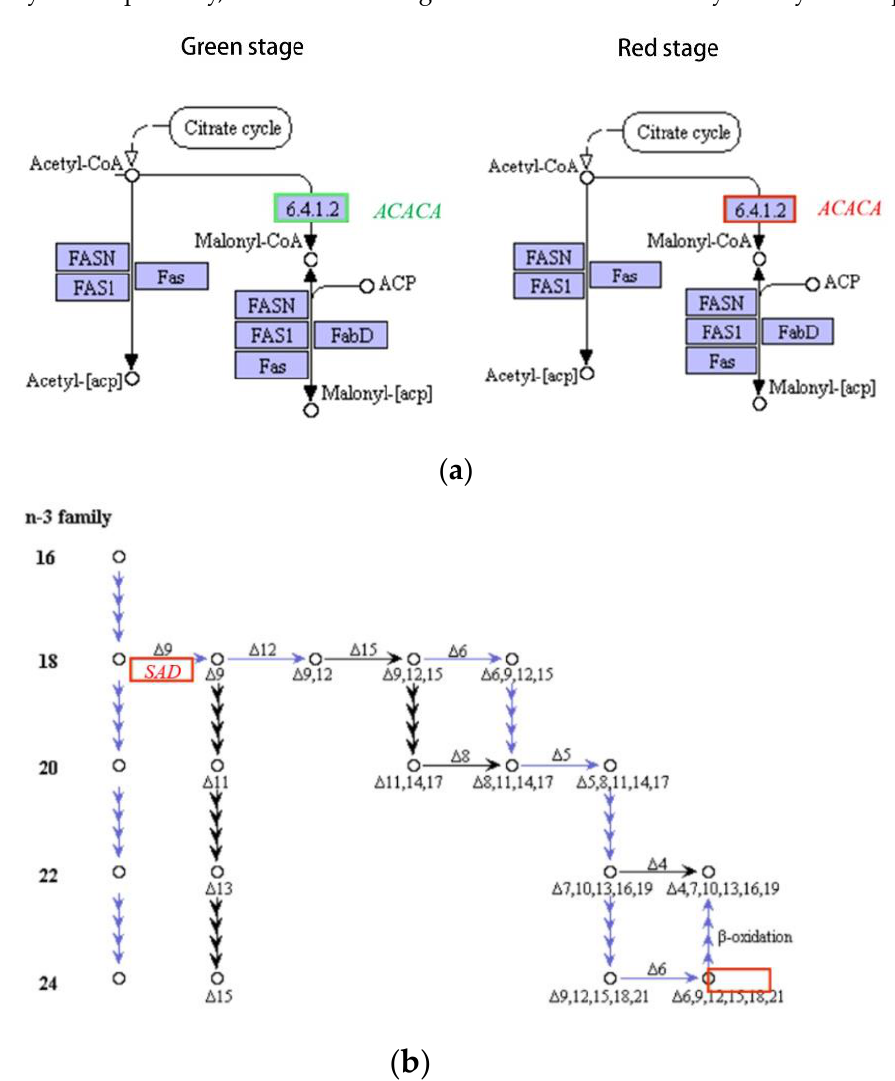
Figure 9. Differences in gene expression of genes related to fatty acid metabolism. Red indicates upregulation and green indicates downregulation. Note: only partial metabolic pathways are shown, the same below. ( a ) Acetyl-CoA carboxylase gene ( ACACA ), green stage on the left and red stage on the right; ( b ) stearoyl-CoA desaturase gene ( SAD ).